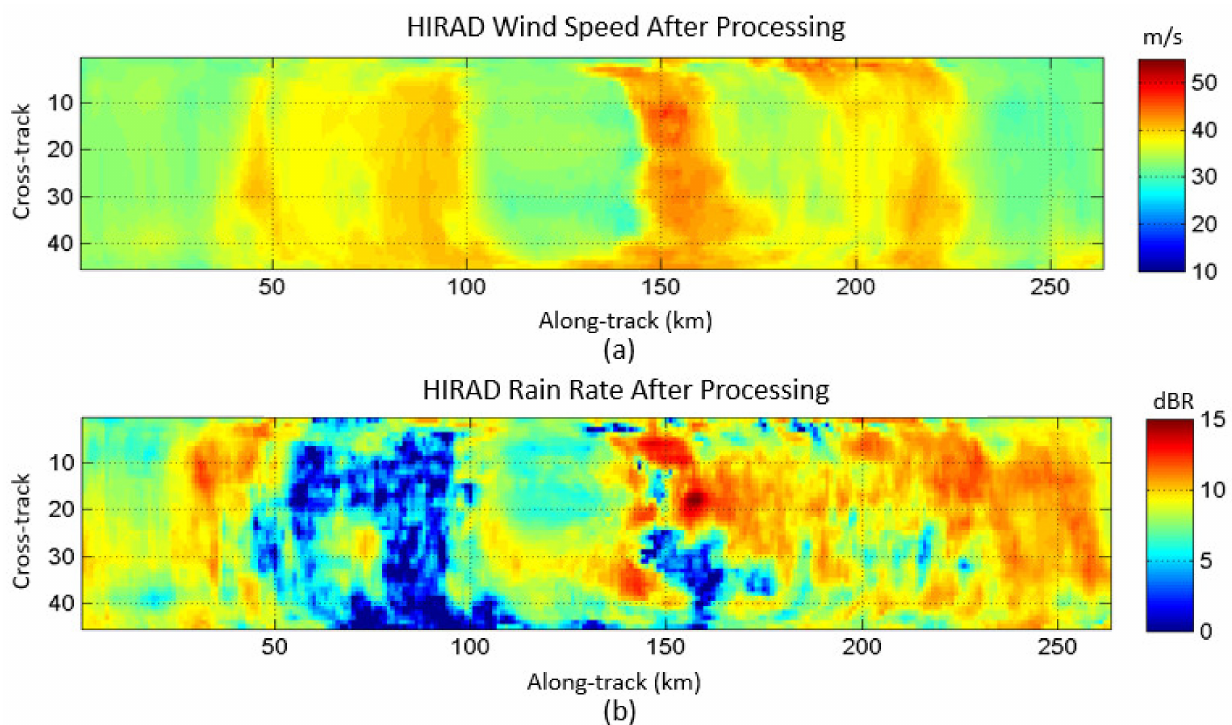
Figure 12. HIRAD-retrieved post-processed ( a ) WS (m/s) and ( b ) retrieved RR (dBR) for Hurricane Gonzalo Leg 4.